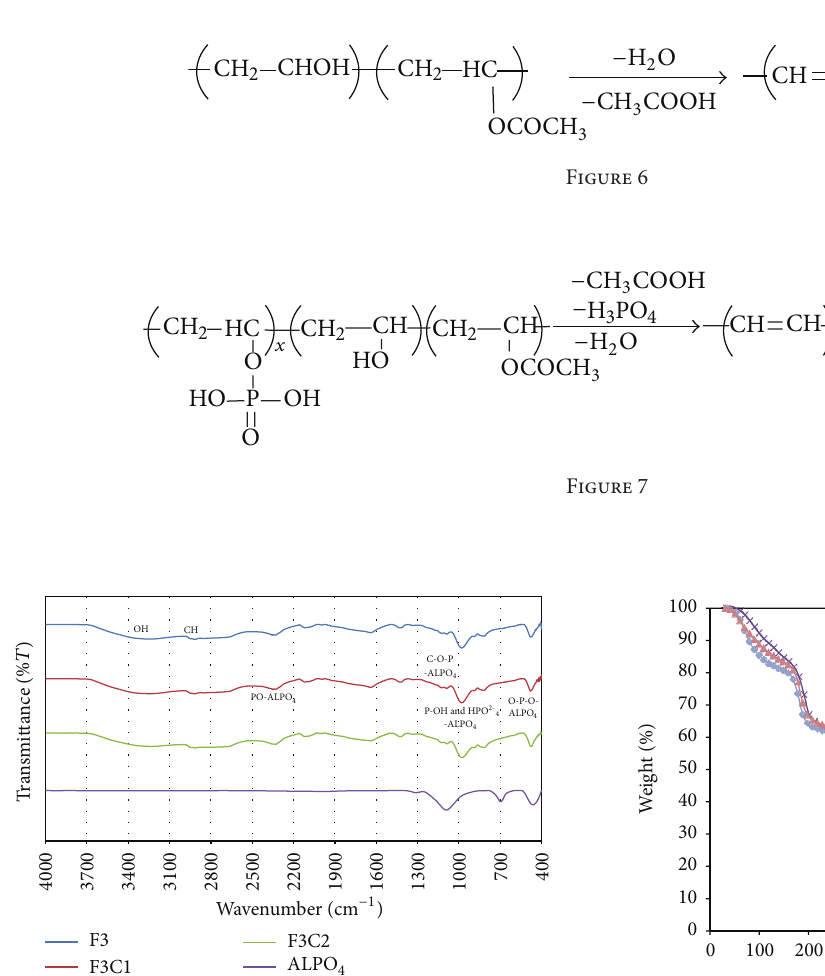
Figure 8: FTIR spectra of PPVA-ALPO 4 composite films.